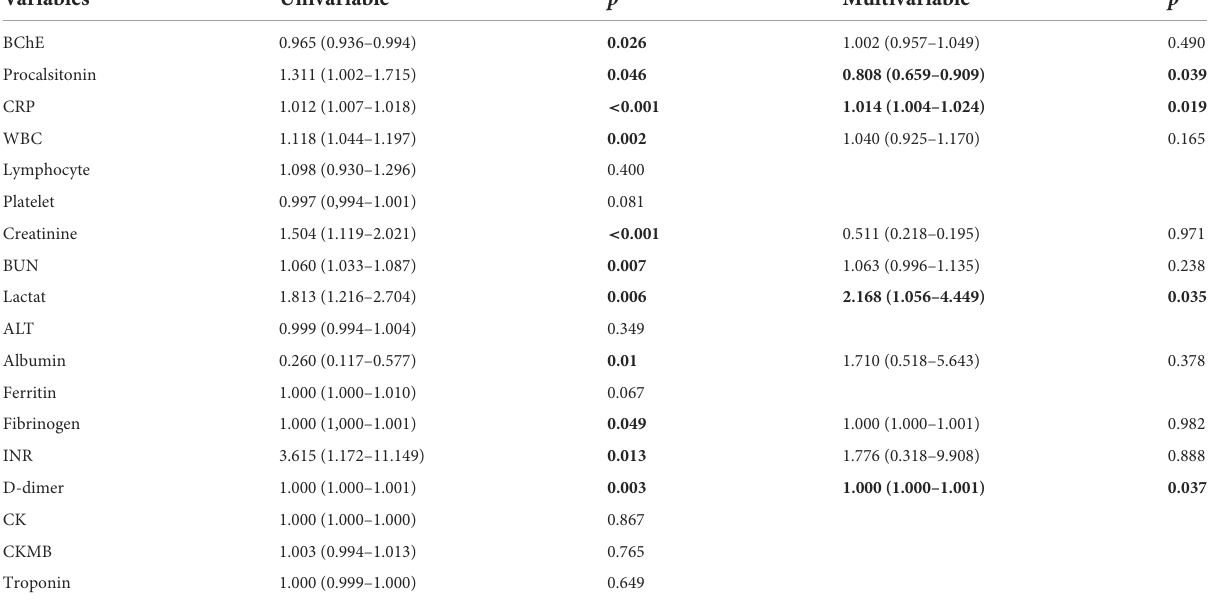
TABLE 3 Blood parameters associated mortality in COVID-19